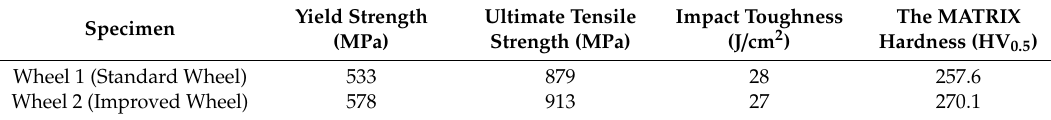
Table 2. Mechanical properties of two